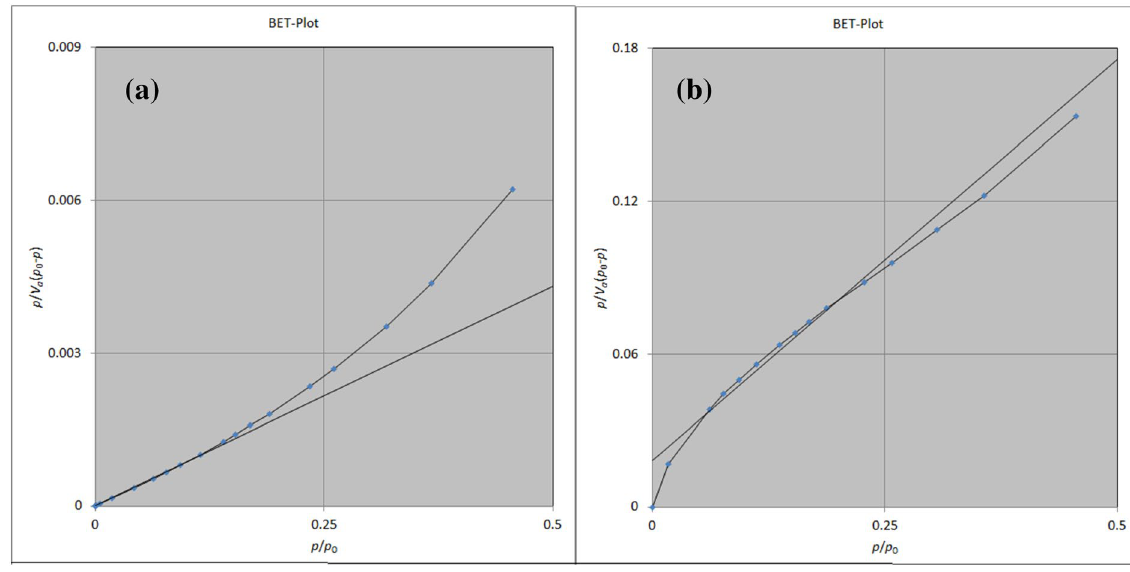
Figure 7. BET-plot of ZIF-8/GO/MgFe 2 O 4 (a) , and ZIF-8/GO/MgFe 2 O 4 /TC (b) .